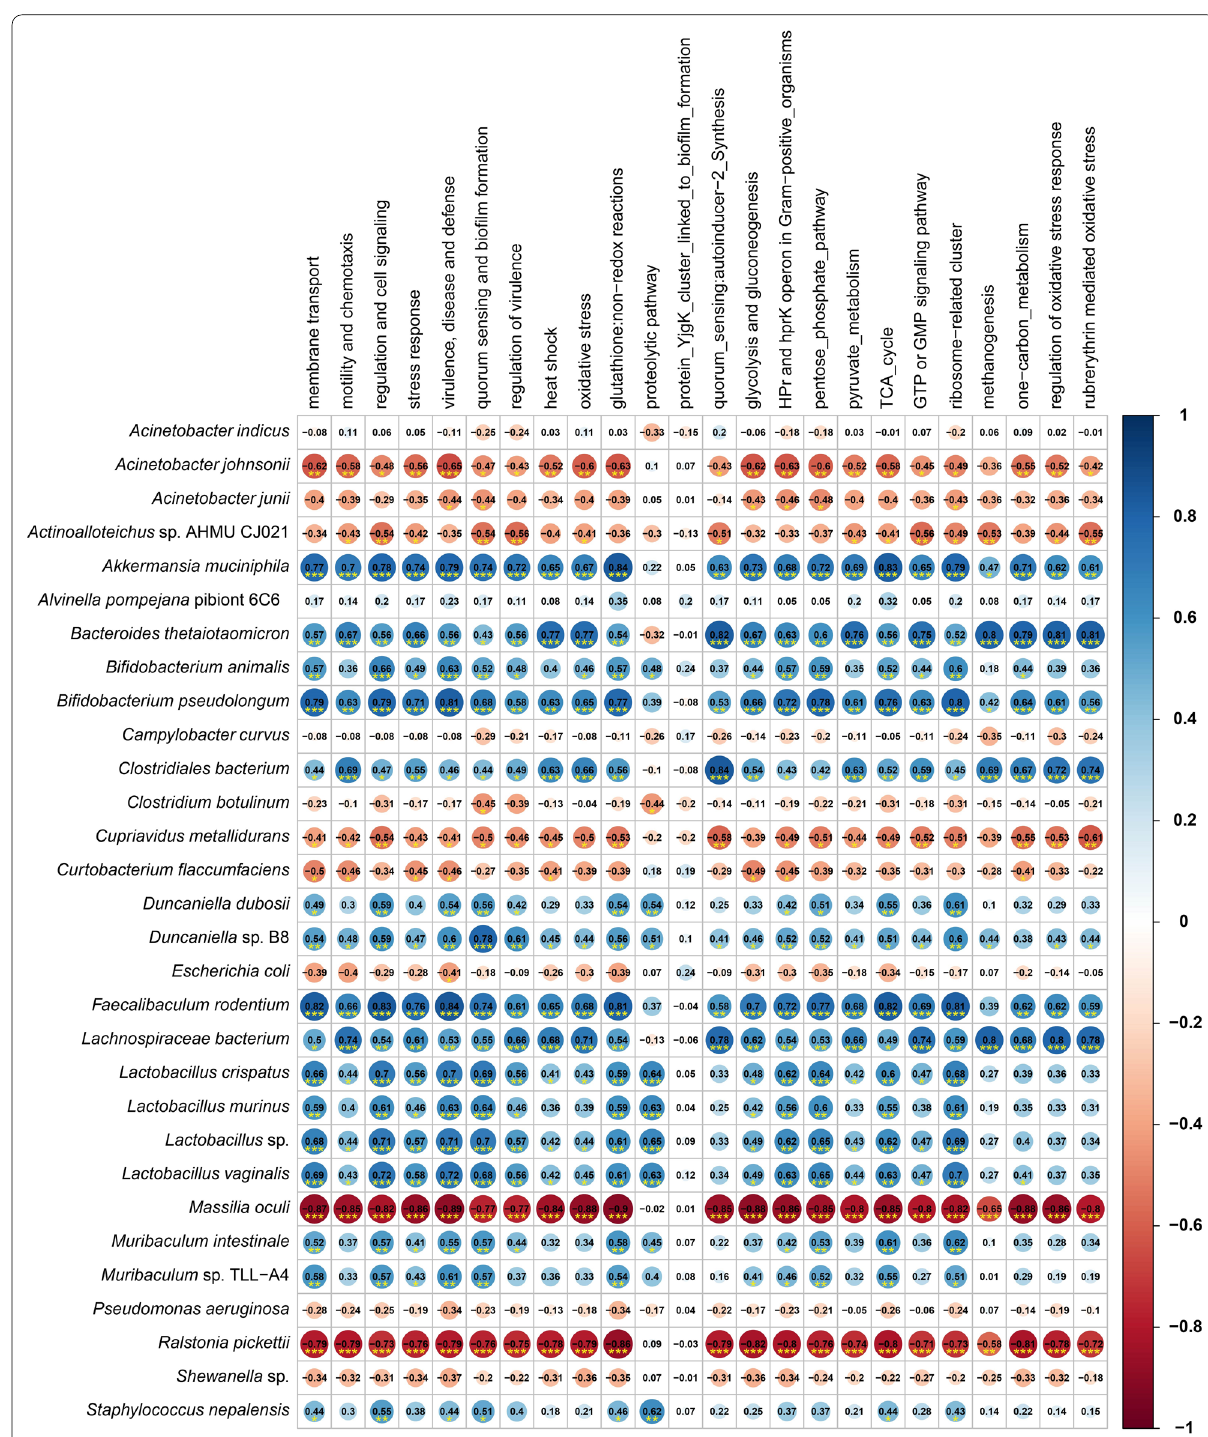
Fig. 10 The correlation between top abundant 30 bacterial species and their genomic functional potentials at different levels of SEED subsystem in CM and H control metagenomes of both cows and mice. The scale bar at the right side of of the heatmap represent the Spearman’s correlation coefficient (r). Blue and red indicate positive and negative correlation, respectively. The color density, circle size, and numbers reflect the scale of correlation. *Significant level (* p < 0.05; ** p < 0.01; *** p <